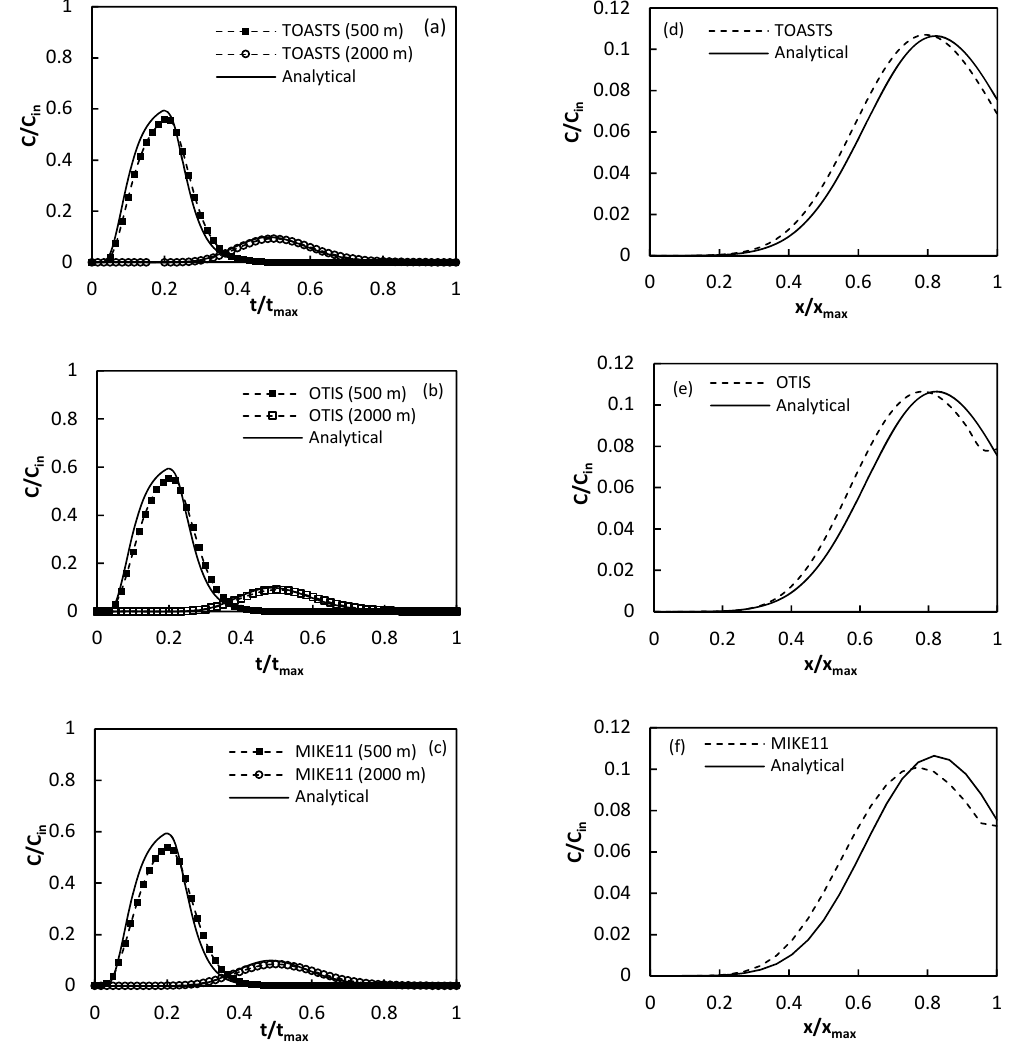
Figure 10. Comparison of the TOASTS, OTIS and MIKE 11 models in test case 2 for Pe =